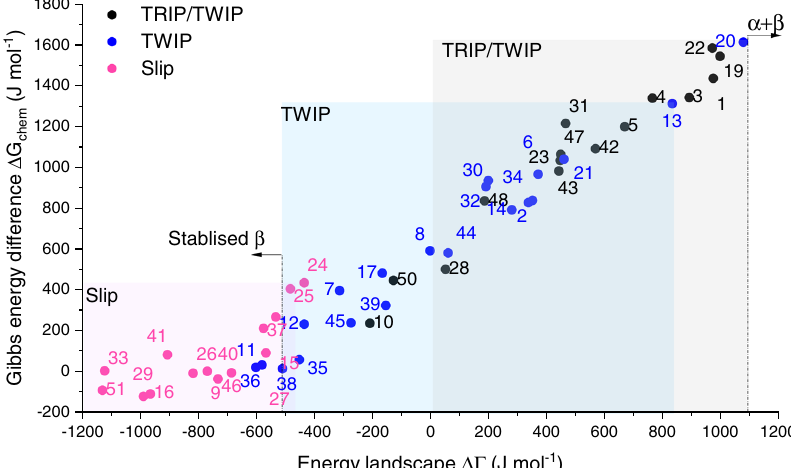
Fig. 5 Energy landscape ΔΓ vs. Gibbs free energy change Δ G chem . The alloys were labelled corresponding to the number in Table 3. A clear boundary was identi fi ed between the stabilised β -alloy and the metastable alloys. The energy domains of TWIP alloys and TRIP/TWIP alloys exhibit large overlapping area, suggesting deformation twinning and strain-induced martensite are mutually inclusive for most of the compositions in this